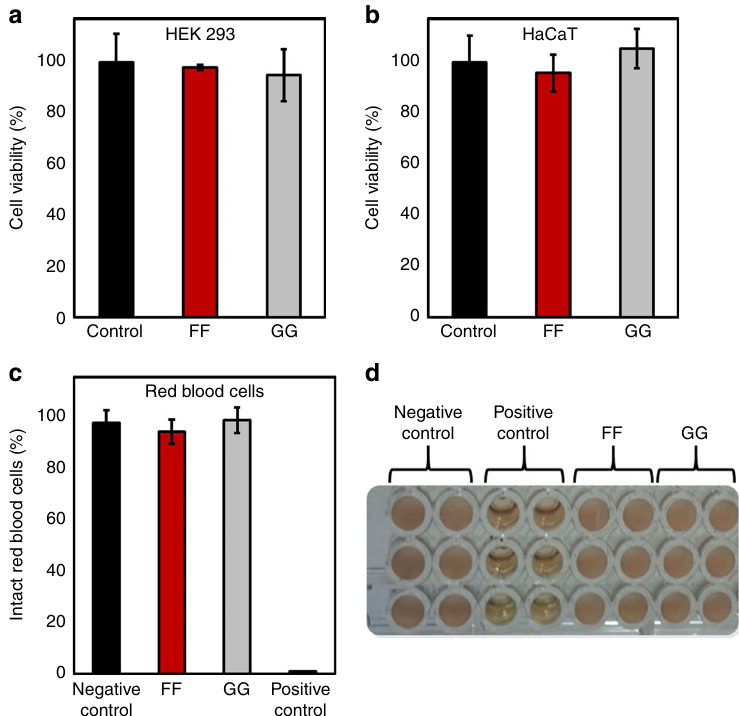
Fig. 4 The diphenylalanine nanostructures are non-hemolytic and non-cytotoxic toward human cell lines. a , b MTT cell viability analysis. The cytotoxicity of the diphenylalanine nanostructures toward two human cell lines was evaluated by the MTT assay using the NAD(P)H-dependent Tetrazolium dye following over-night treatment with the indicated compounds. a HEK 293 embryonic kidney cell line. b HaCaT keratinocyte cell line. c , d Hemolysis analysis. The hemolytic activity of the diphenylalanine nanostructures was assessed by incubating de fi brinated sheep blood with the compounds and calculation of the subsequent hemolysis from absorbance readings at 451 and 405 nm. The percentage of non-disrupted blood cells is presented c , as well as the treated pelleted erythrocytes